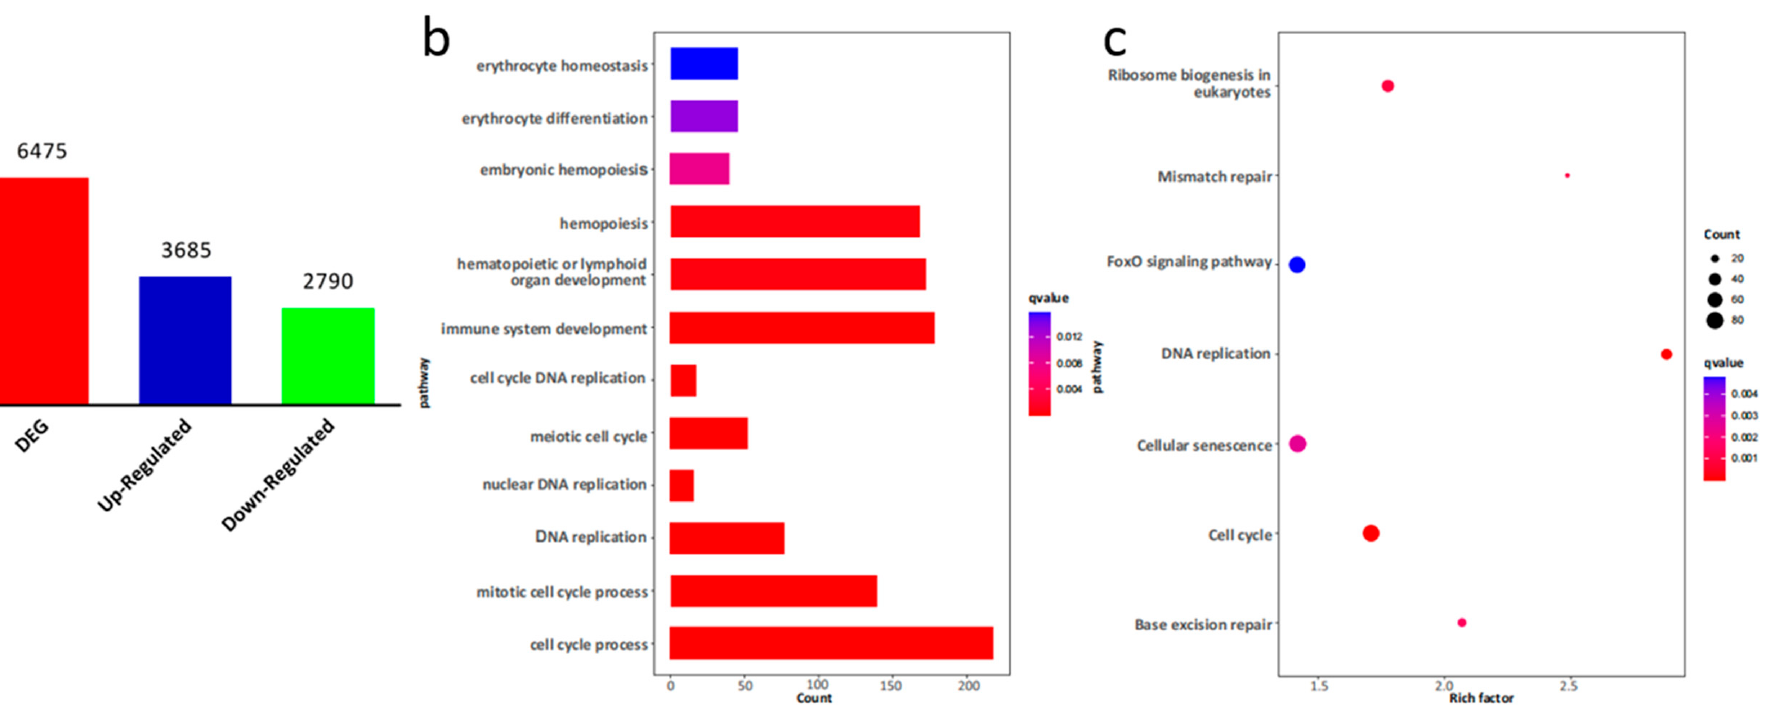
Figure 3. Differentially expressed genes (DEGs) between the long-term hypoxia acclimated zebrafish and the normoxia zebrafish. ( a ) Statistical analysis of DEGs in the head kidney. ( b ) GO enrichment analysis of the DEGs. ( c ) KEGG annotation of DEGs.